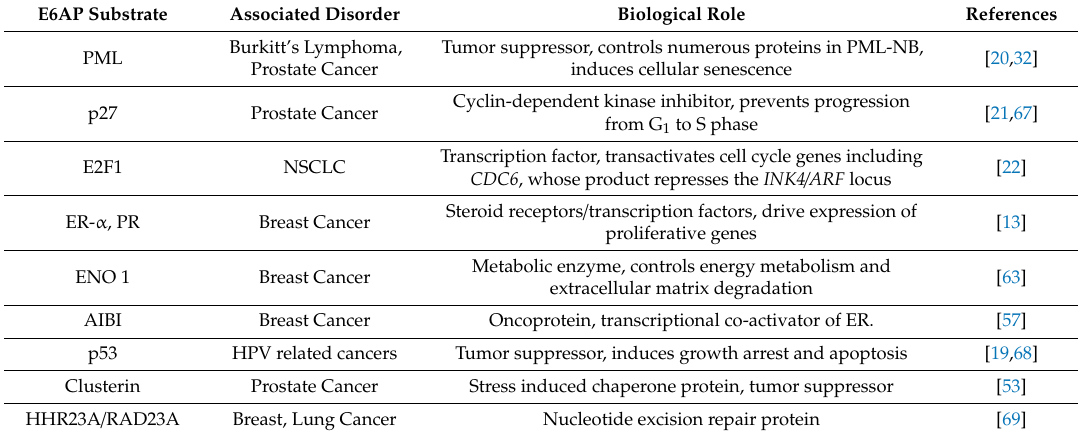
Table 1. E6AP Substrates in